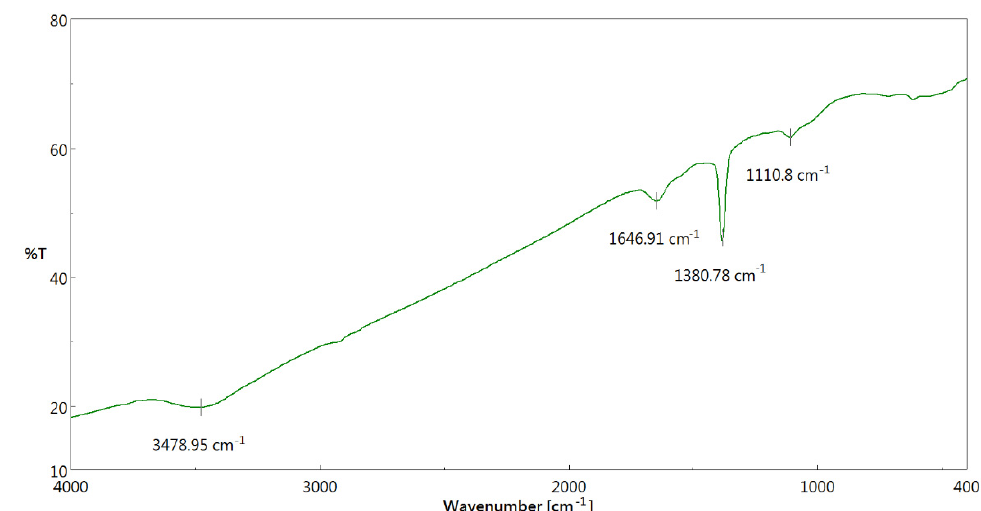
Figure 6. FTIR spectrum of the biochar product (PP-BC-900-20).